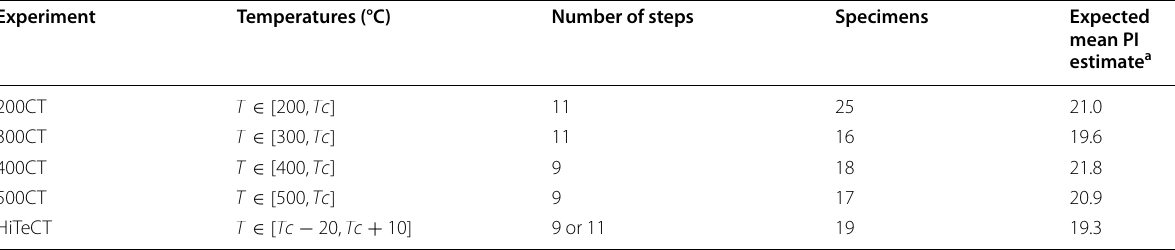
Table 3 Summary of experiments run for this study Experiment